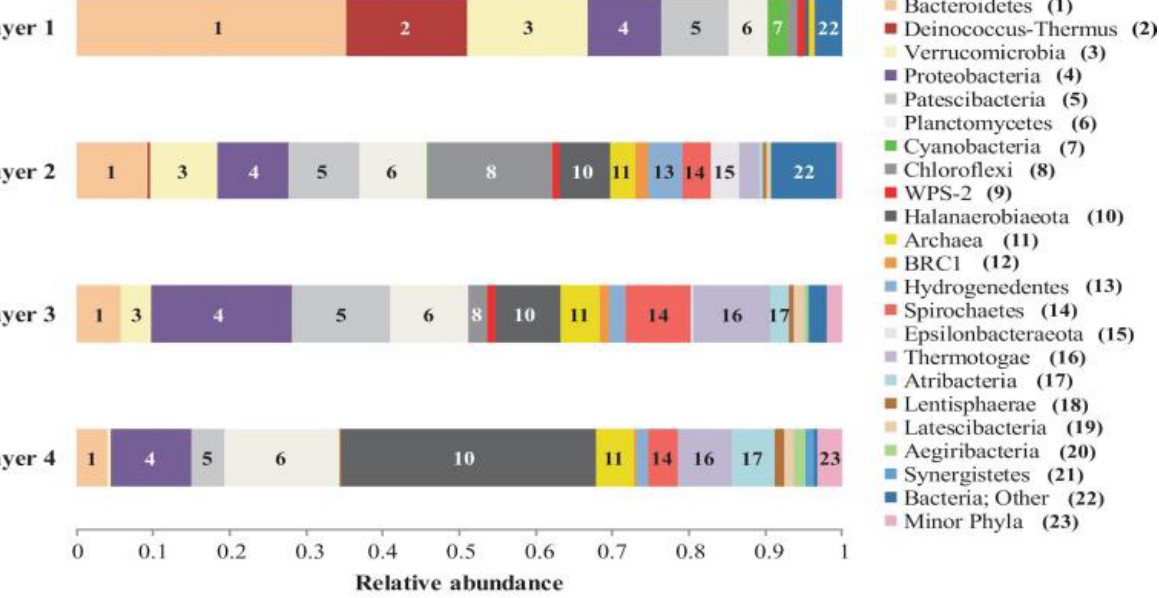
Figure 4. Relative abundance of bacterial phyla and Archaea in the Laguna Negra microbial mat layers. Assignations are derived from sequences analysis of the V4 hypervariable region of 16S